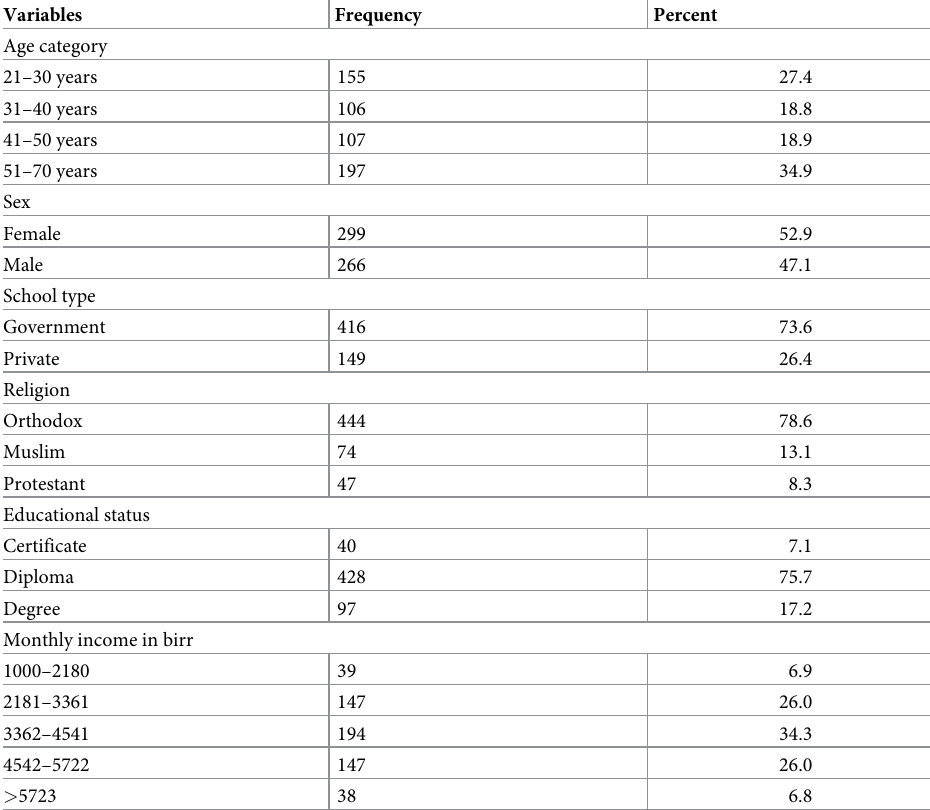
Table 1. Socio-demographic characteristics of study participants in Gondar city, Northwest Ethiopia, 2017.